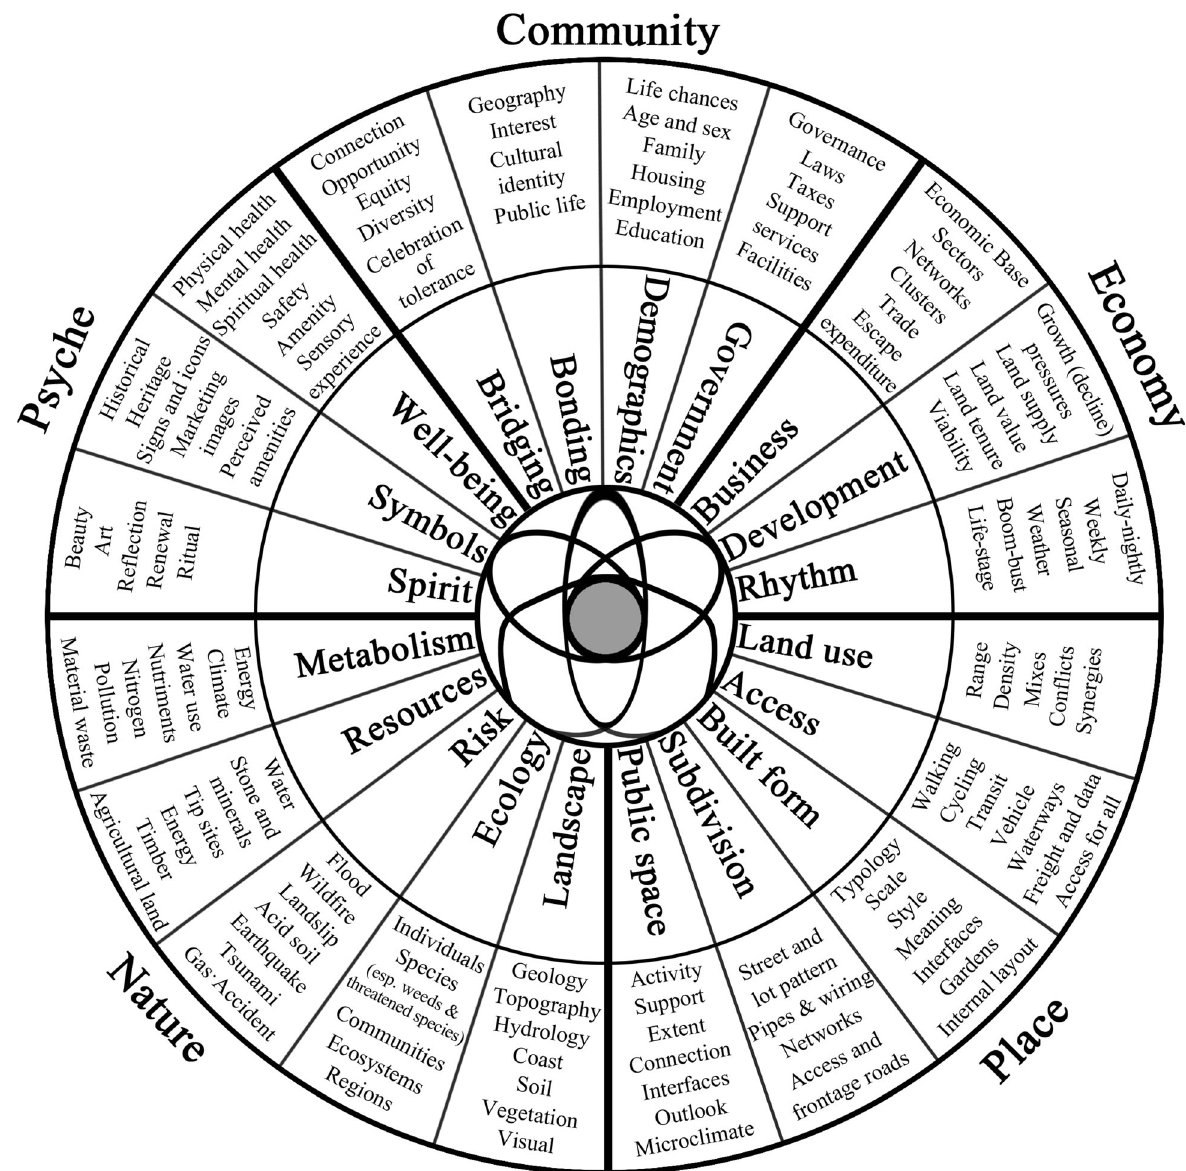
Fig. 5 Contemporary strategic planning theory aligns with the objectives of adaptive reuse by Townsend. (Source: Townsend 2015; Redrawn by the author